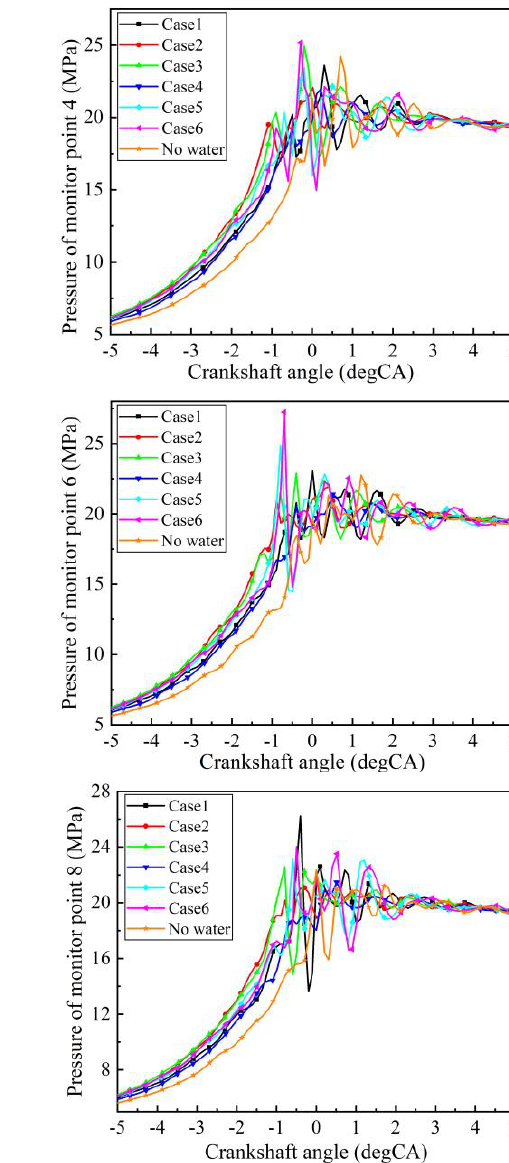
Figure 13. Pressure curves of eight monitor points in different water injection cases (CR = 10.3, ignition time = − 14 degCA).